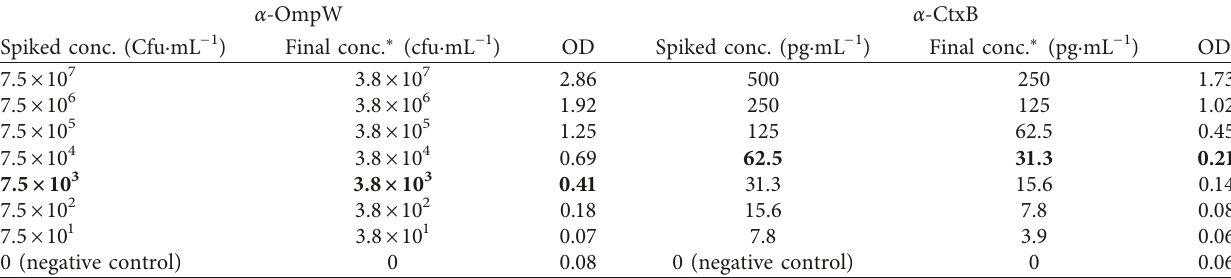
Table 4: The result of analytical sensitivity and specificity of the developed ELISAs in spiked stool sample. α -OmpW α